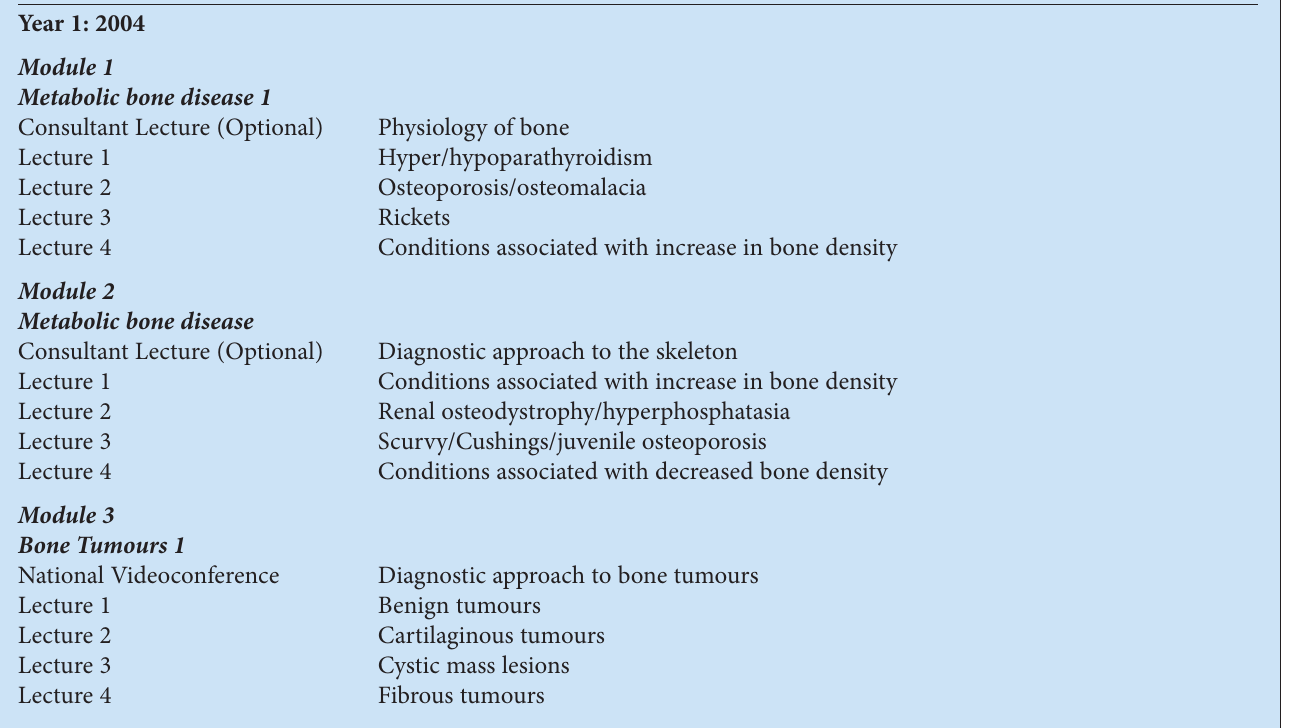
Table II. Example of detailed content of one module composed of between four and five 20-minute lectures for each module (on 1 day per